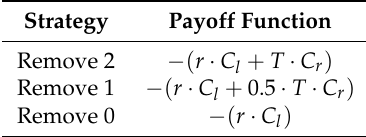
Table 1. Payoff functions for the different strategies.